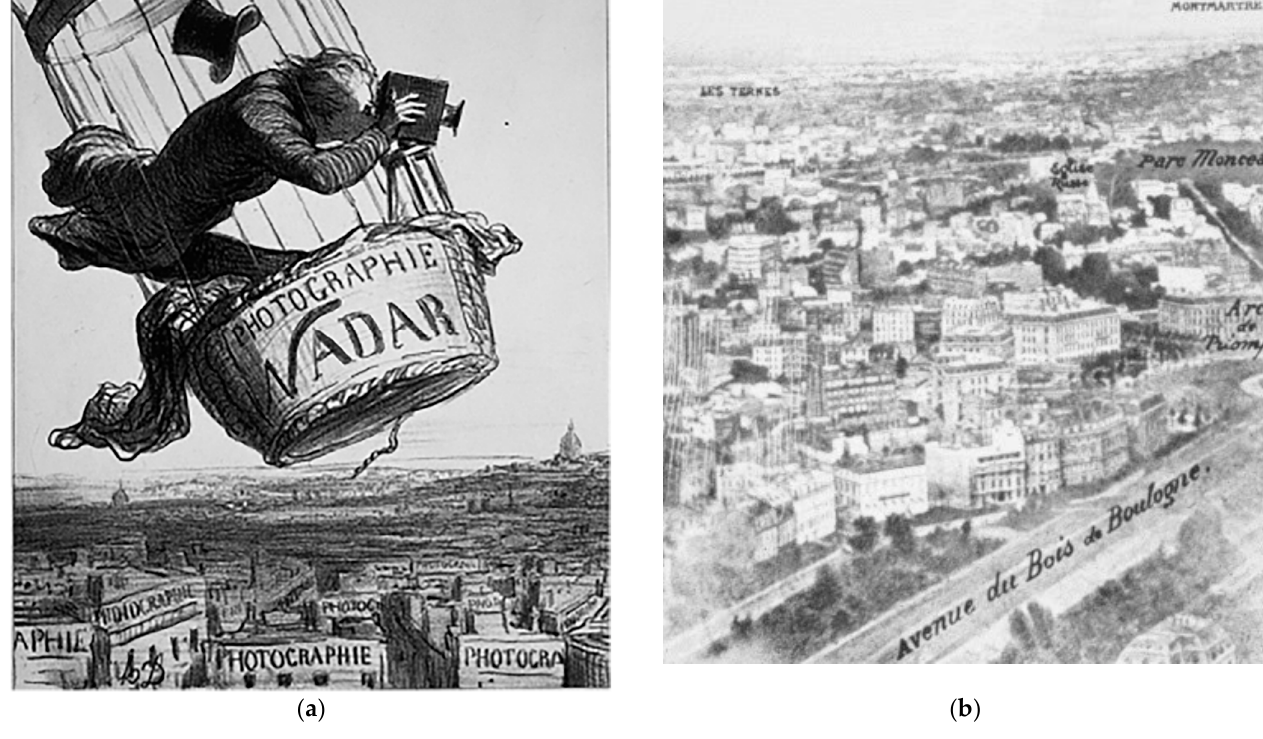
Figure 7. ( a ) Daumier, Nadar elevating photography to the level of art (1862) ( b ) Nadar early aerial photograph of Paris c 1860 (source: The adventures of Nadar photography, ballooning, invention and the impressionists by Philip McCouat).